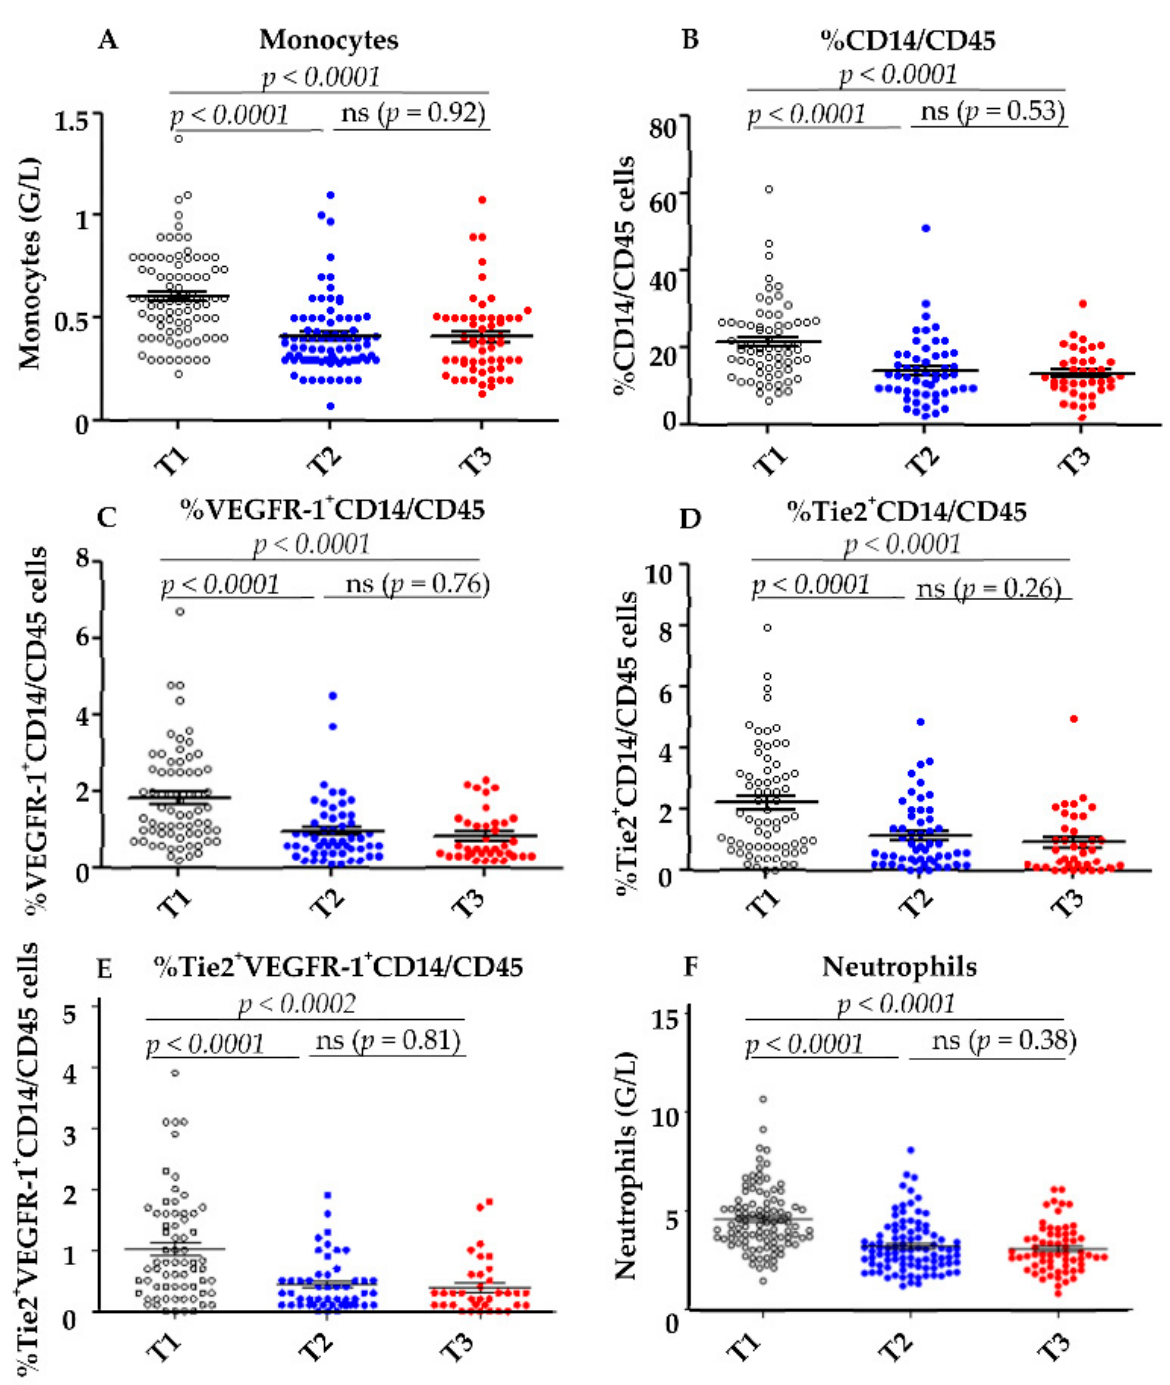
Figure 3. Decrease of myeloid cells during anti-angiogenic therapy. ( A ) The total number of mono- cytes and neutrophils ( F ) was determined by automatic hematologic cell count before (T1) and after the first cycle (T2) and at the end of anti-angiogenic therapy (T3). The percentage of CD14 + within CD45 + cells ( B ) and the percentage of VEGF-R1 + ( C ) and Tie2 + ( D ) and VEGFR-1 + Tie2 + ( E ) within CD14 + cells were determined by cytometry before (T1), after the first cycle of anti-angiogenic therapy (T2), and at the end of anti-angiogenic therapy (T3). Statistical analysis was performed with GraphPad Prism ® software using the paired t -test.